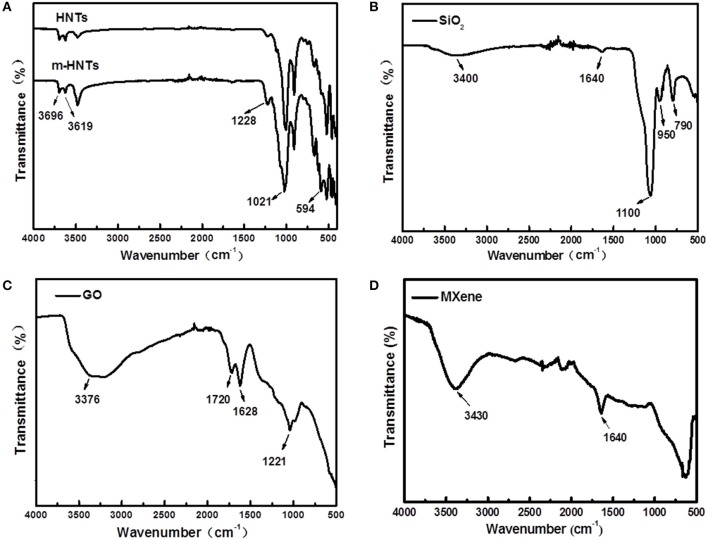
FTIR spectrum of (A) HNTs, (B) SiO2, (C) GO, and (D) MXene.